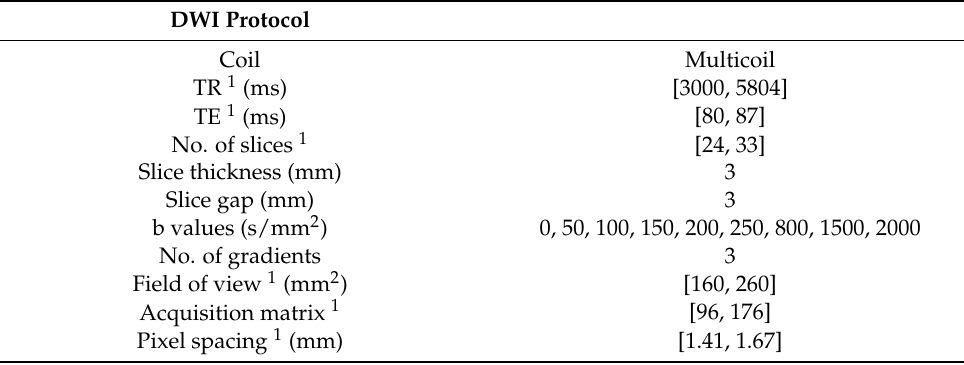
Table 2. DWI acquisition protocol for the seventy-six patients included in the